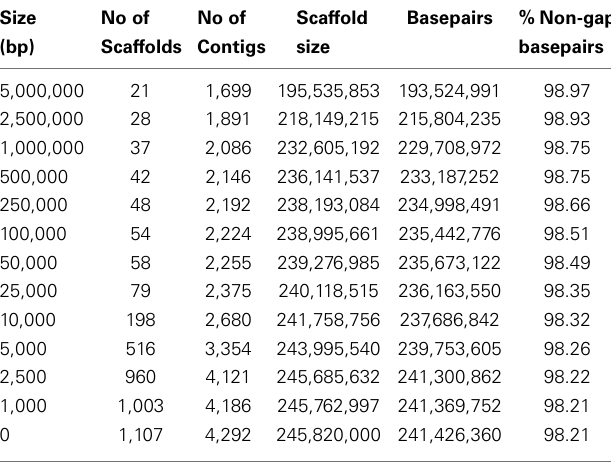
Table 1 | Summary statistics of the output of the whole-genome